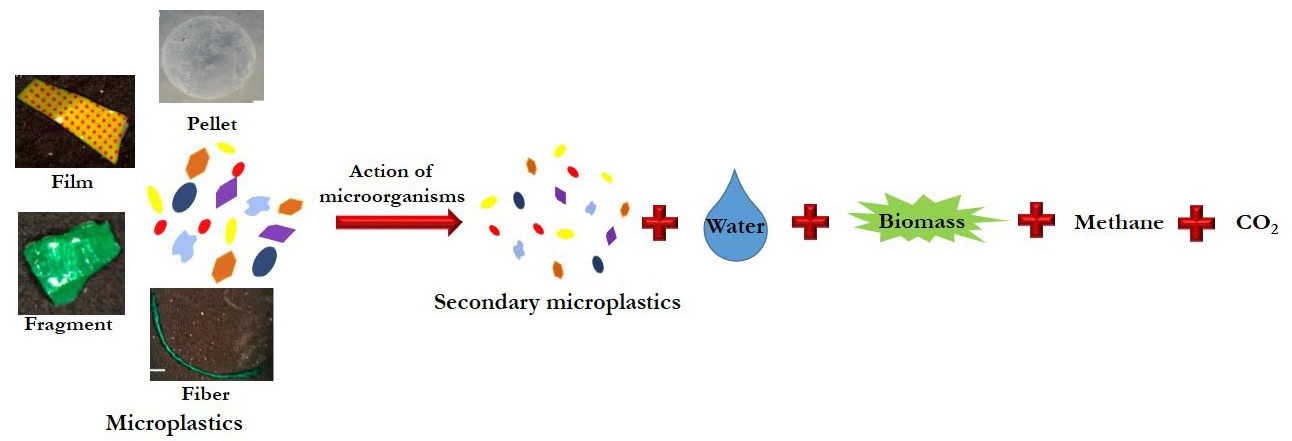
Figure 10. Microbial degradation of microplastics [67].